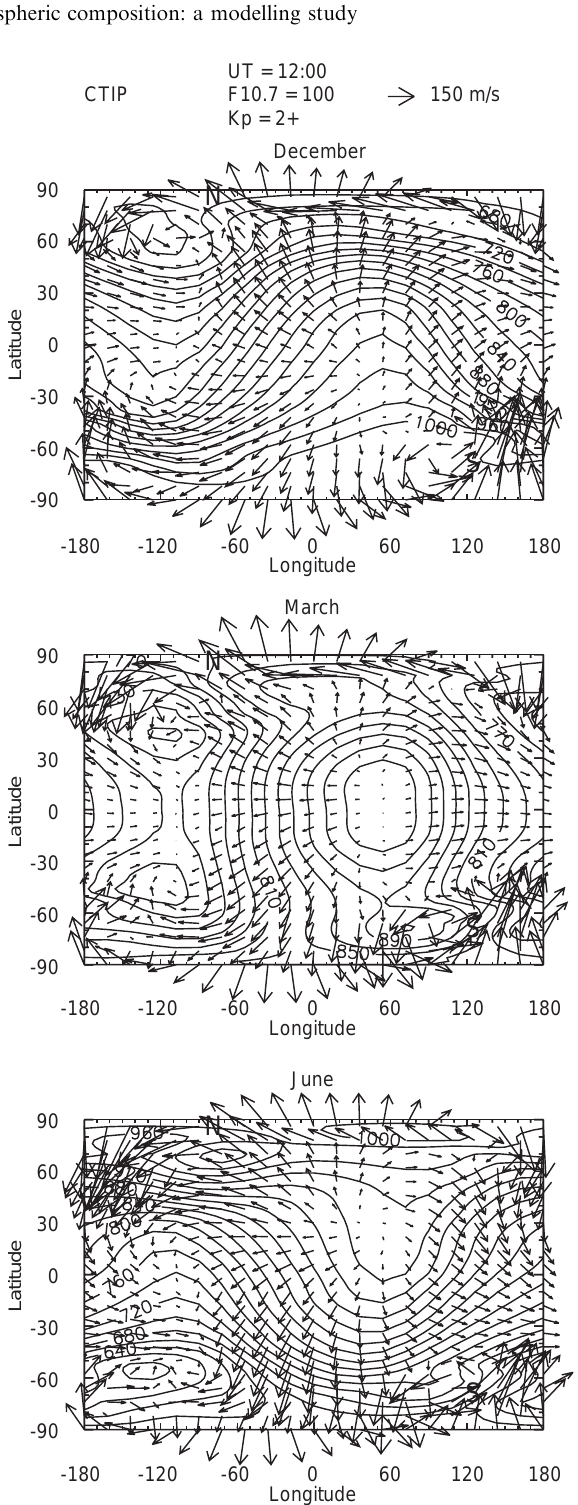
Fig. 1. Horizontal wind and temperature fields for 12 UT at pressure-level Z (cid:136) 15, in geographic latitude and longitude. Letters N ; S mark the positions of the magnetic poles. The minimum and maximum temperatures are as follows: December, 606 and 1073 K; March, 664 and 955 K; June, 606 and 1023 K. The arrow indicates a wind speed of 150 m s (cid:255)